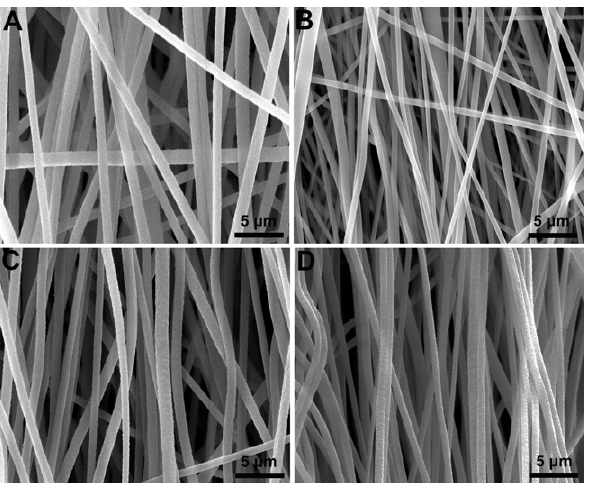
Figure 4: SEM images of aligned PAN nanofiber membranes (12wt%) at different rotary speeds: A) 1000rpm; B) 1500rpm; C) 2000rpm; D) 2500rpm.